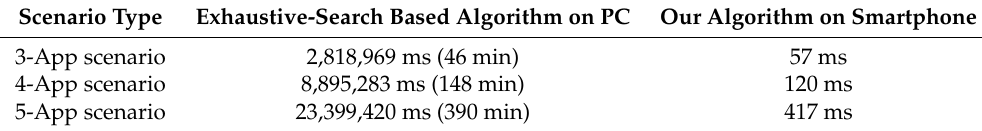
Figure 21. Transient and steady QoS in 3-App, 4-App, and 5-App scenarios. Table 3. Comparison of average execution time of exhaustive-search-based algorithm and our